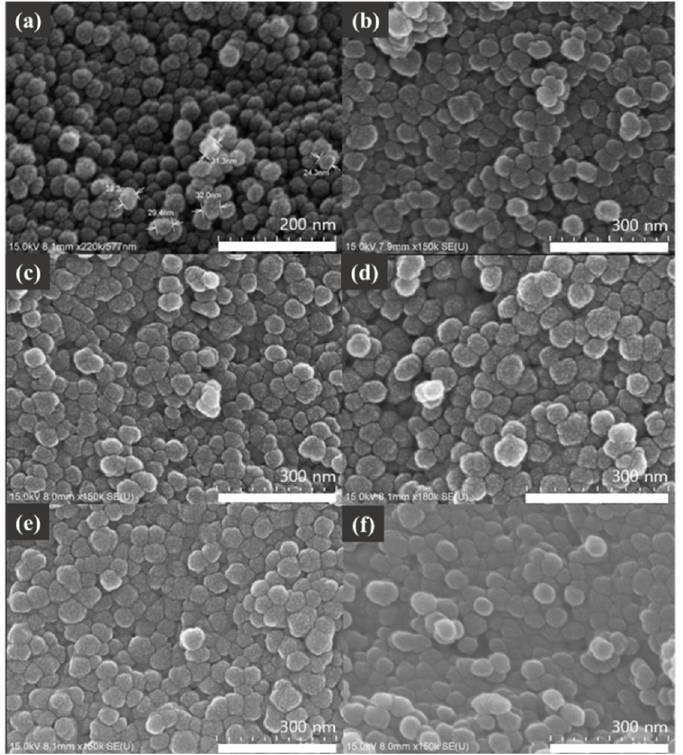
Figure 2. Scanning electron microscope (SEM) images of ( a ) SNPs, ( b ) STF-1, ( c ) STF-2, ( d ) STF-3, ( e ) STF-4, and ( f ) STF-5.